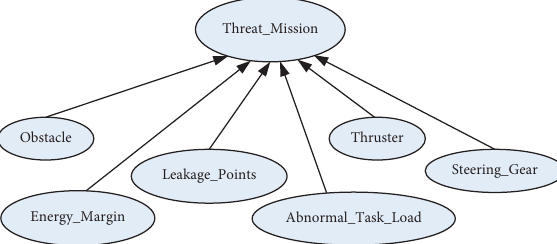
Figure 7: Bayesian network of uncertain